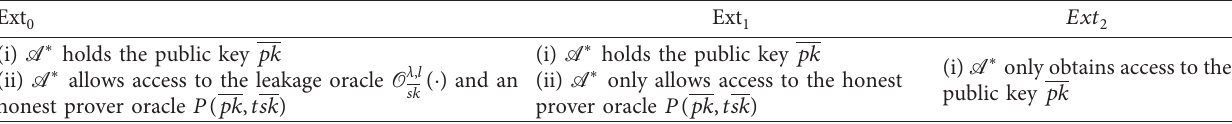
Table 3: Experiments performed by the adversary A ∗ .